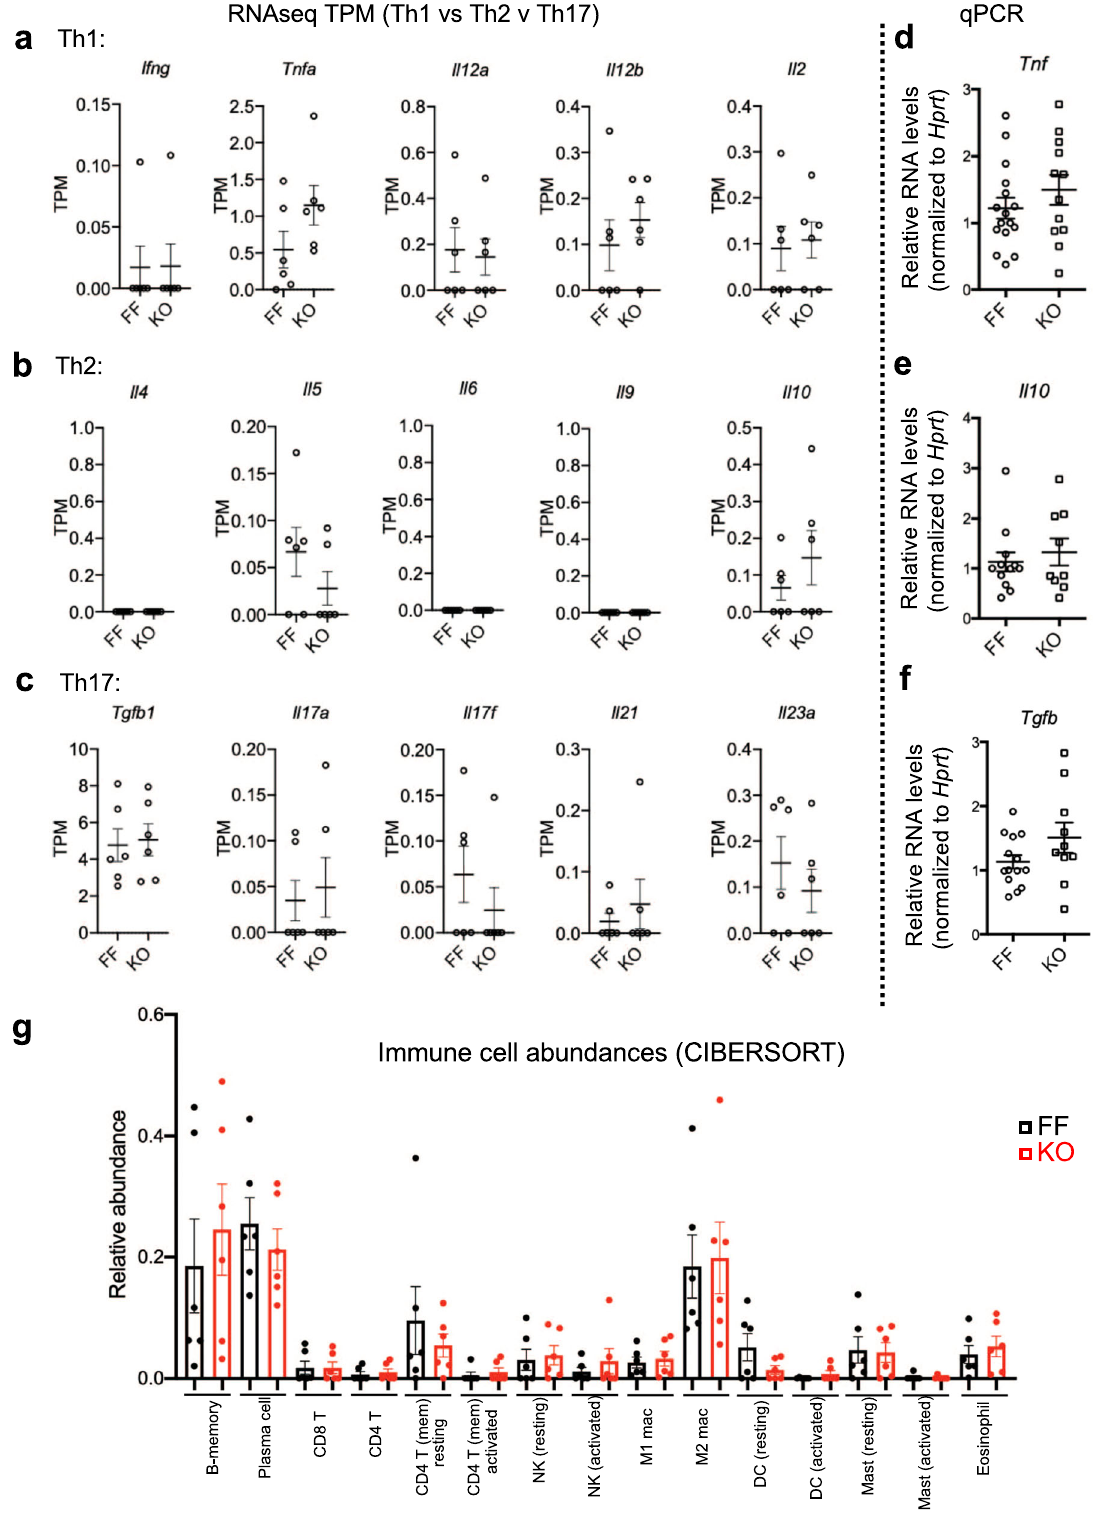
Fig. 5 Canonical markers of Th1, Th2, and Th17 immunity are unchanged in Spry2 IEKO mice. RNA sequencing was performed on distal colonic homogenates from Spry2 FF and Spry2 IEKO mice. a – c Expression levels (as transcripts per million, TPM) of canonical Th1, Th2, and Th17 cytokines were compared between groups; n = 6 mice per group. d – f Expression of principal drivers of Th1, Th2, and Th17 immunity were con fi rmed by qPCR in a larger cohort of mice ( Tnf , n = 16 FF, 12 KO; Il10 ; n = 12 FF, 9 KO; and Tgfb , n = 14 FF, 10 KO). g The relative abundance of immune cell subtypes was estimated in distal colons of Spry2 FF and Spry2 IEKO mice by CIBERSORT; n = 6 mice per group. Data are presented as mean ± SEM. Analyzed by two-sided t